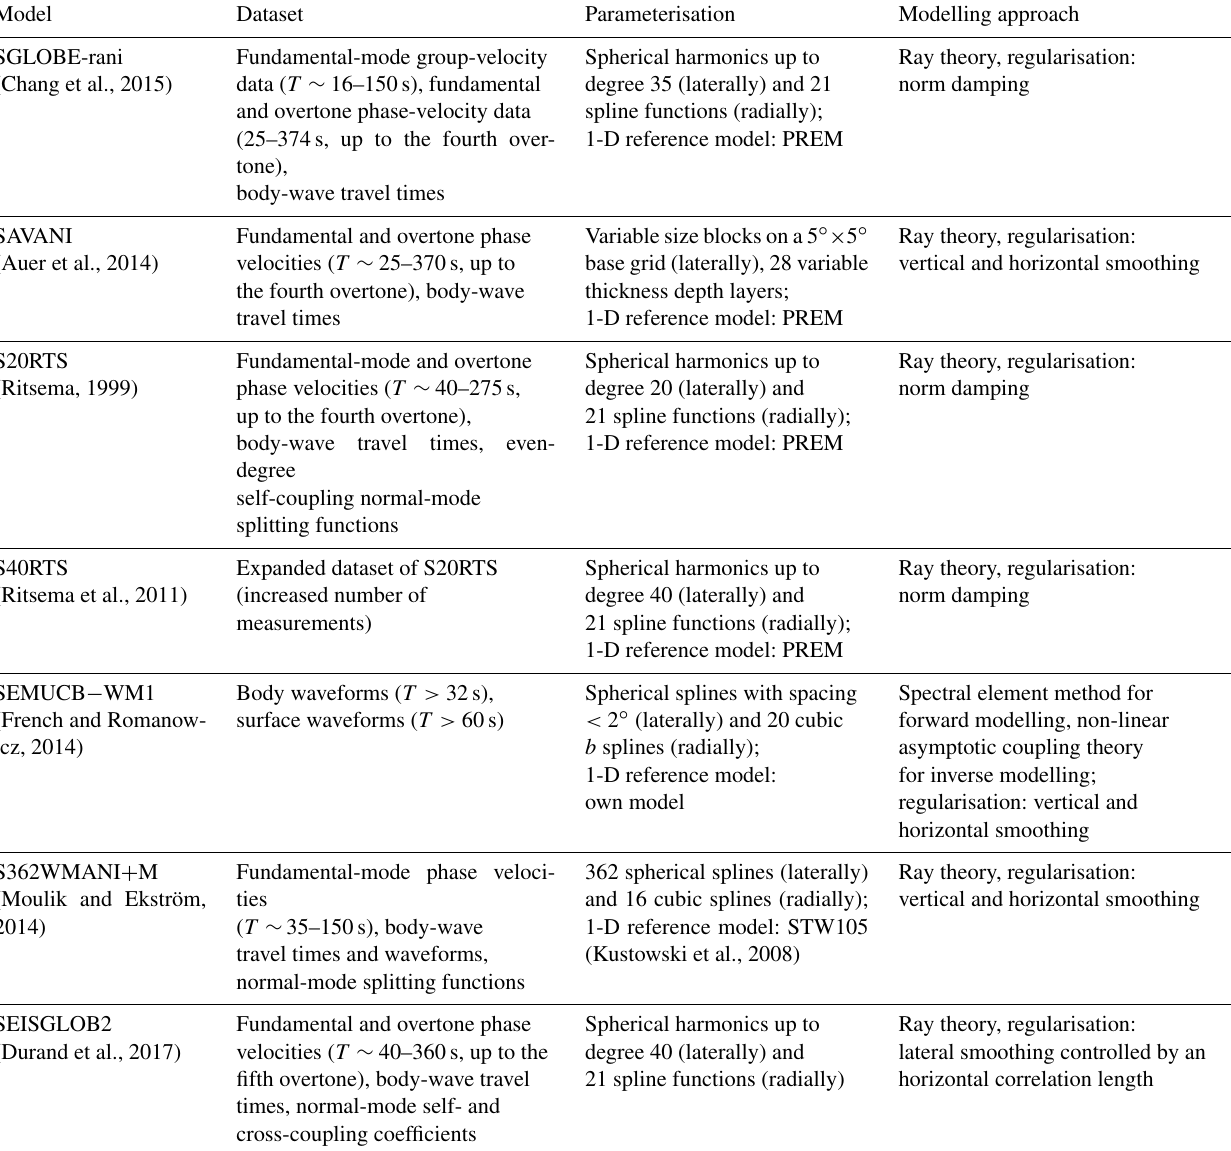
Table 1. Global tomography models used in this study, including a short description of the data, parameterisation and the modelling approach used in their construction. All models were built using least-squares inversions with different regularisation